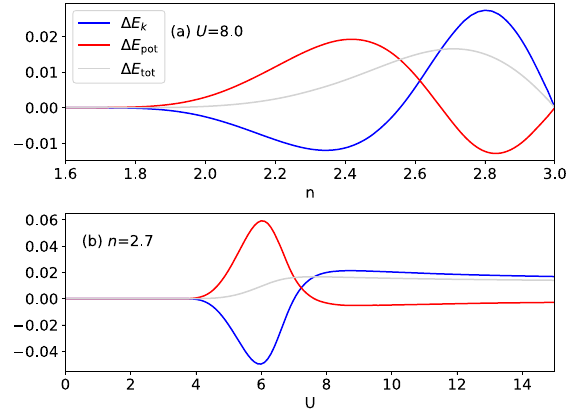
FIG. 12. Kinetic energy Δ E , potential energy Δ E , and total k pot energy gain Δ E for the superconducting paring state (a) as a tot function of electron filling n at U ¼ 8 t and T ¼ 10 − 4 t and (b) as a function of Coulomb interaction U and J ¼ U= 4 at n ¼ 2 . 7 and T ¼ 10 − 4 t